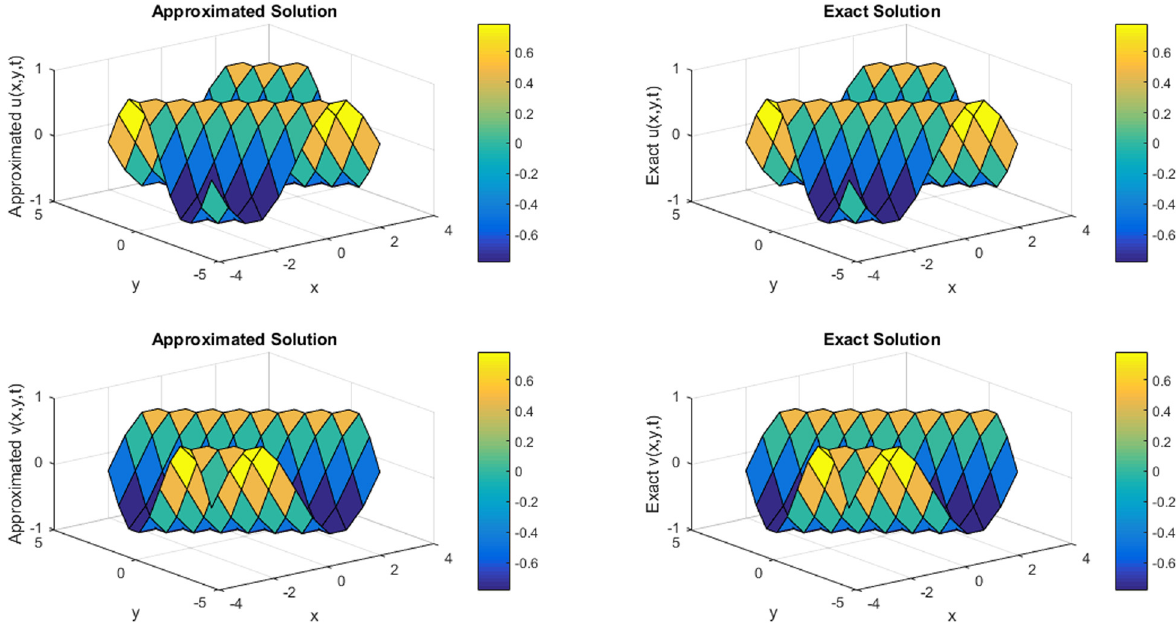
Figure 5: 3D plot for comparison of approximated and exact results at t = 0.1 with ρ = 1 and N = 11 for ϕ and ψ components regarding Example 3.